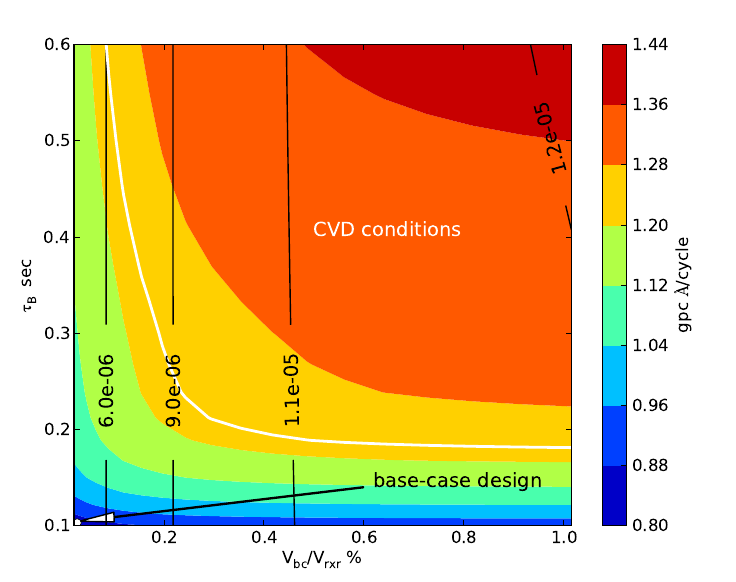
/V and V . The black curves B bc rxr